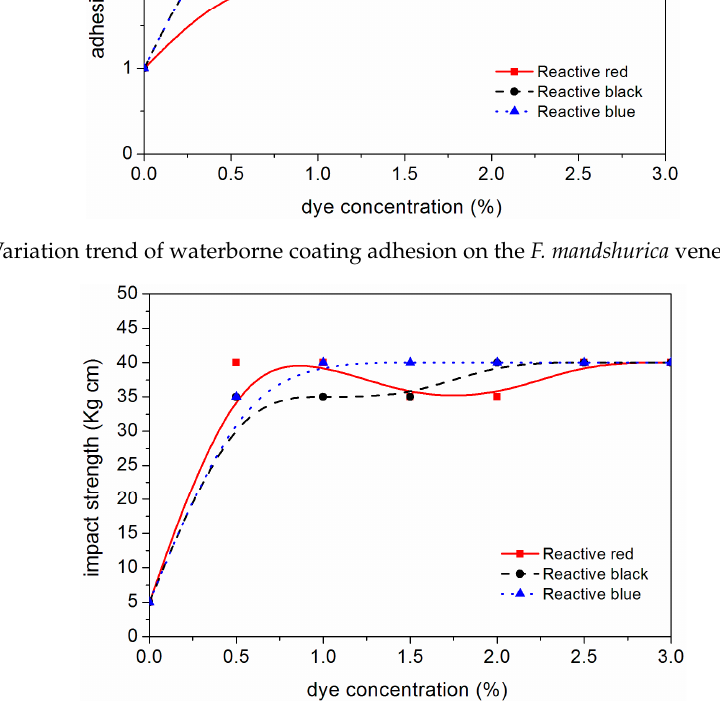
Figure 10. Variation trend of waterborne coating impact strength on the F. mandshurica veneer after dyeing.